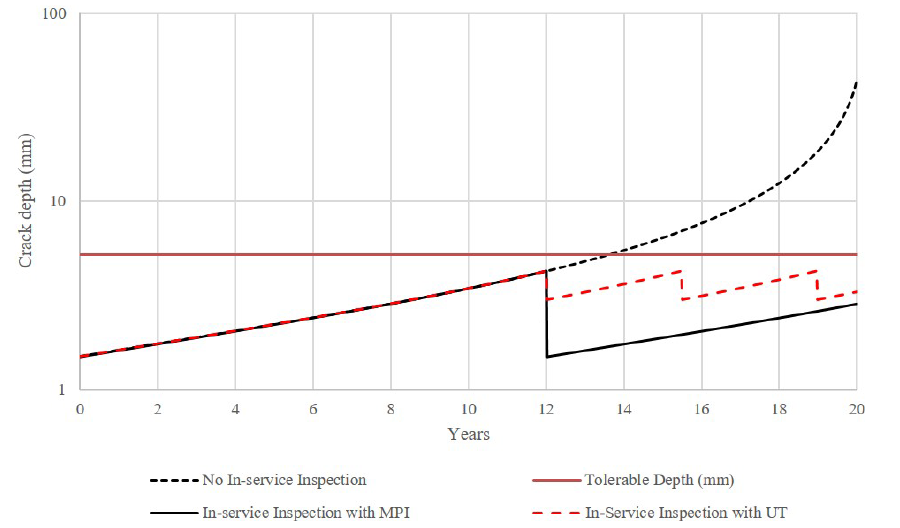
Figure 23. Selection of NDT method based on probability of detection and crack size at the time of